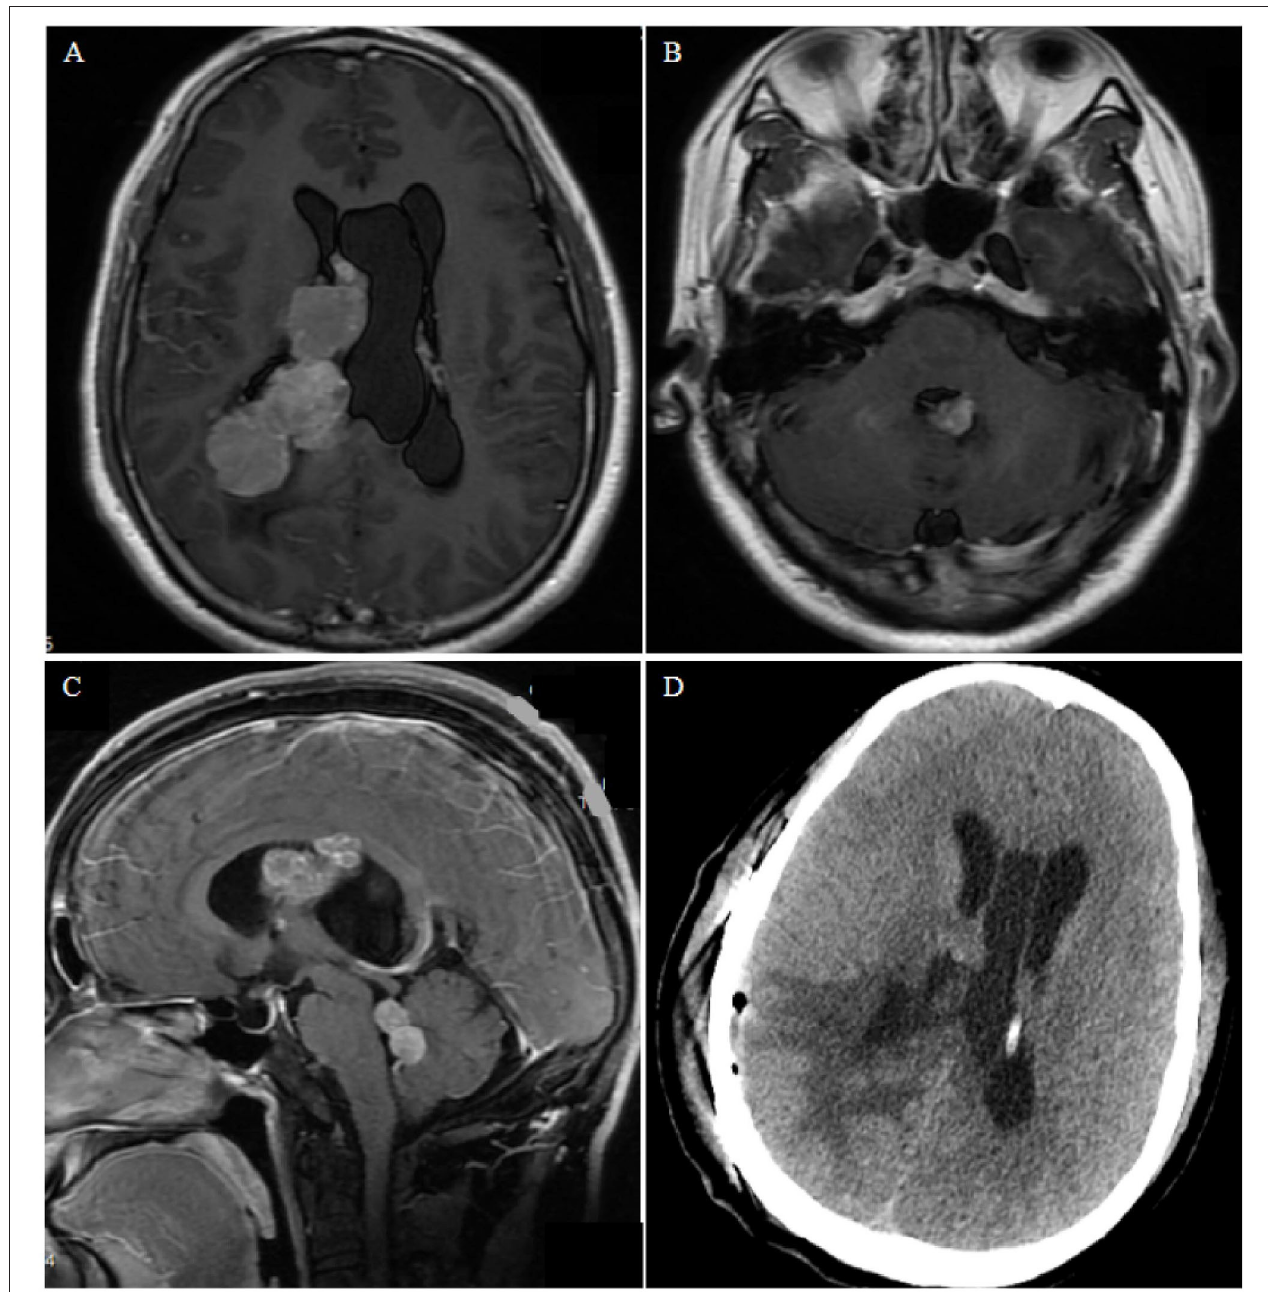
FIGURE 3 | Case 2. (A,B) Contrast-enhanced T1-weighted axial images show nodular bead-like lesions in the right and fourth ventricles. (C) Sagittal magnetic resonance images showing multiple lesions occupying the midbrain aqueduct and fourth ventricle. (D) Postoperative computed tomography shows edema of brain tissue and no bleeding in the operative